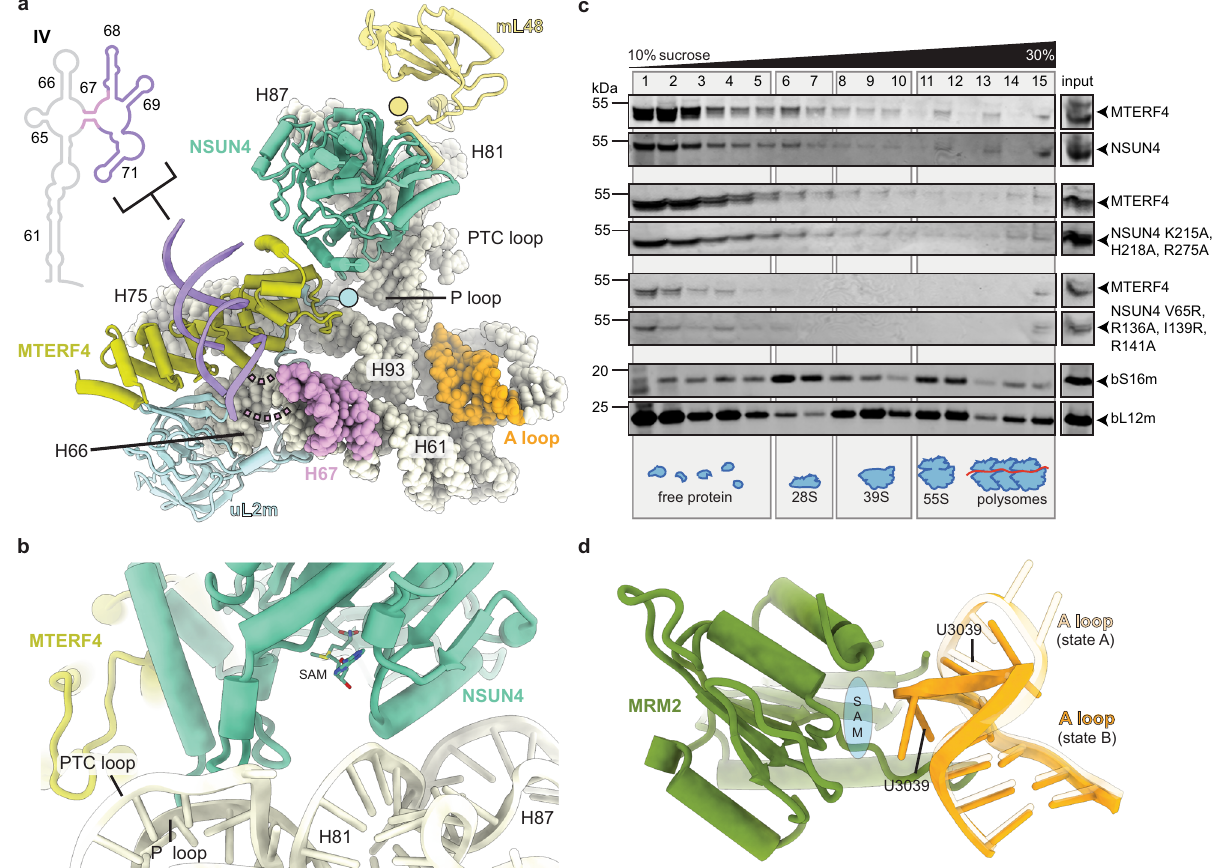
Fig. 2 Interactions of NSUN4 and MTERF4 with the immature human mitoribosomal large subunit. a The NSUN4 – MTERF4 heterodimer (teal and light green, respectively) in state A forms a number of contacts with the mitochondrial large subunit via rRNA (beige spheres) and ribosomal proteins, resulting in rearrangements of the mL48 (yellow) and uL2m (light blue) C-termini (highlighted as circles), as well as stabilization of the H68 – H71 region (violet) of the 16S rRNA domain IV. The connection from helix H67 (pink) to H68 – H71 is shown as dashed lines. The A loop, which is modi fi ed by MRM2 in state B, is colored orange. b The NSUN4 (teal) active site with bound S-adenosyl-methionine (SAM) cofactor in state A is shown together with nearby rRNA helices H81, H87, P loop, and PTC loop (beige cartoon). MTERF4 is also shown for orientation (light green). c Effects of mutations in NSUN4 on its association with mitoribosomal fractions were analyzed by immunoblotting. A continuous 10 – 30% sucrose gradient was used to separate mitochondrial lysates from mitochondrial ribosomal fractions. The small and large ribosomal subunit and polysomes in mitochondria isolated from wild-type cells were followed by immunoblotting for mitochondrial ribosomal protein markers of the small (bS16m) and large (bL12m) ribosomal subunits. The input mitochondrial lysate was used as a positive control. The blots are representative of results obtained with at least three independent biological experiments. Source data are provided as a Source Data fi le. d Rearrangement of the A loop (light orange: state A; orange: state B) upon the MRM2 methylation event (state B). The likely position of MRM2 SAM cofactor, which is not visible in our structure, is schematically shown in (Fig. 2a). Interestingly, NSUN4 is an RNA m 5 C methyltransferase